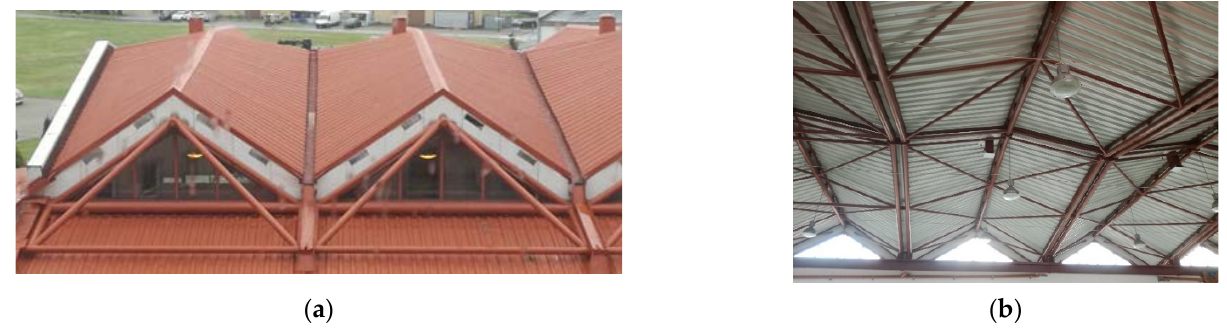
Figure 5. A shell structure of a few transformed shells roofing an experimental hall: ( a ) an outside view ; ( b ) an inside view.